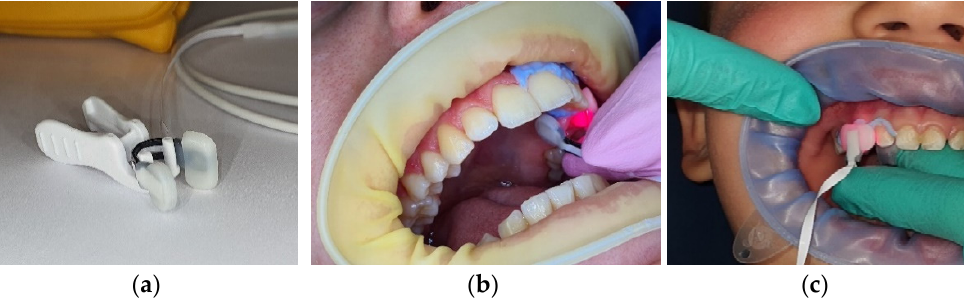
Figure 3. ( a )The small alar sensor together with a fixation clamp; ( b ) SpO 2 % determination in a per- manent superior canine; ( c ) SpO2% determination in a primary superior canine.